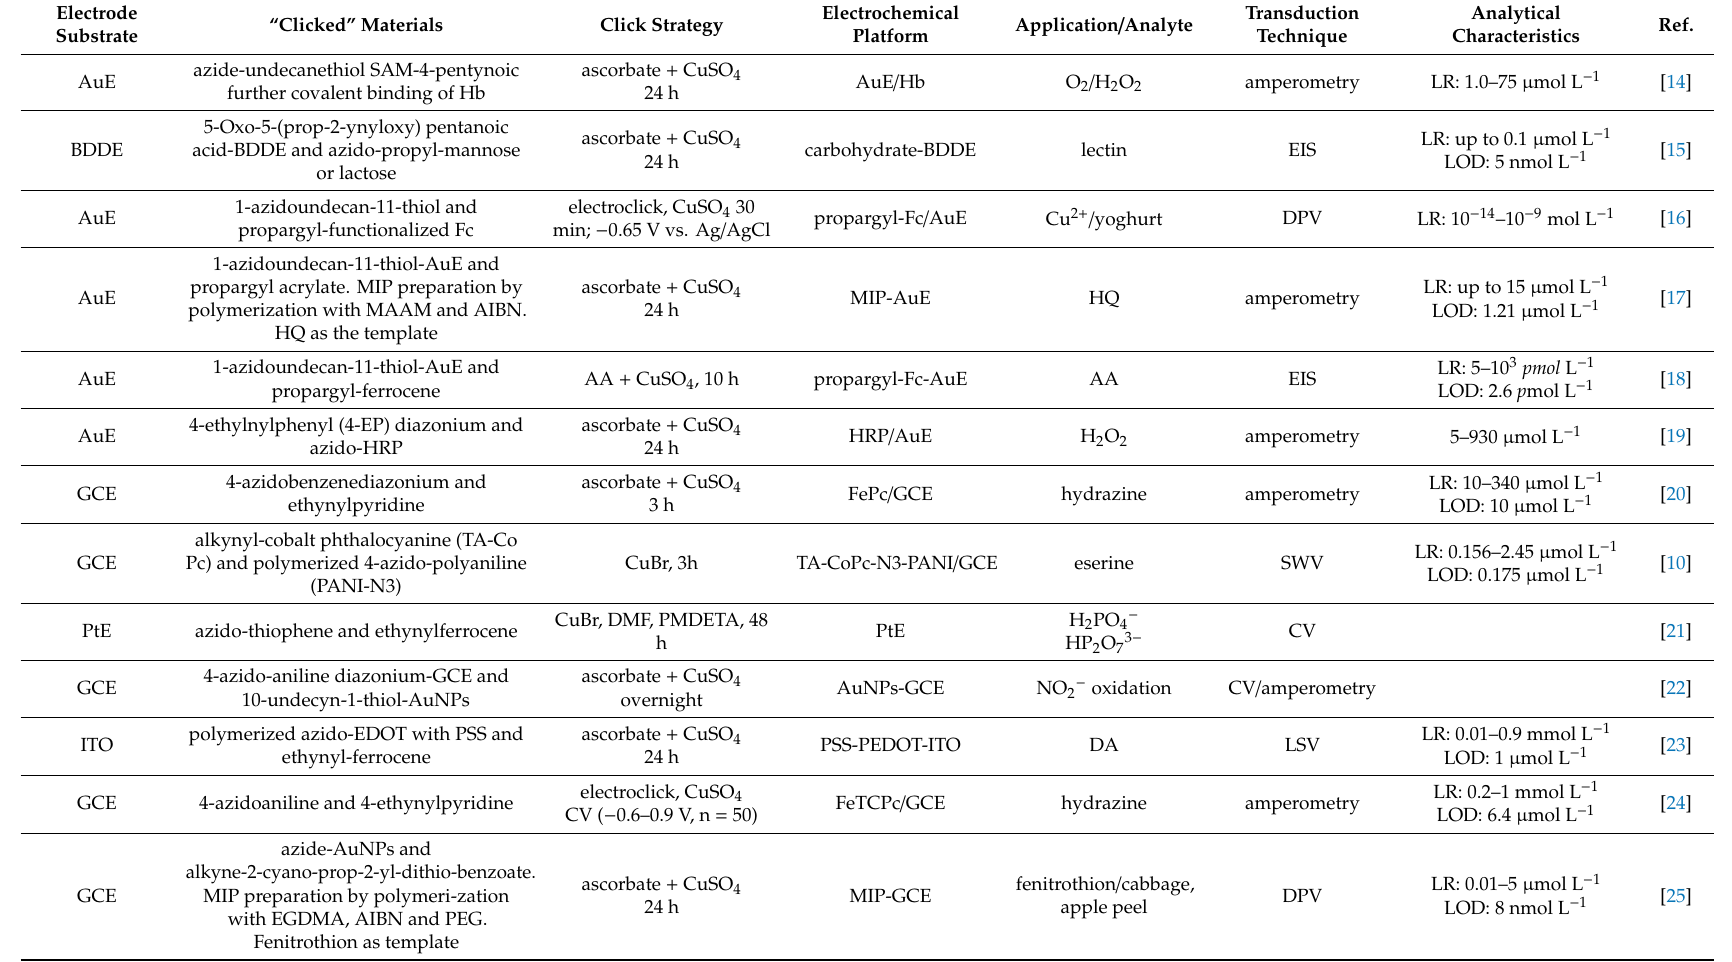
Table 1. Electrochemical platforms prepared by Cu(I)-catalyzed azide–alkyne cycloaddition (click